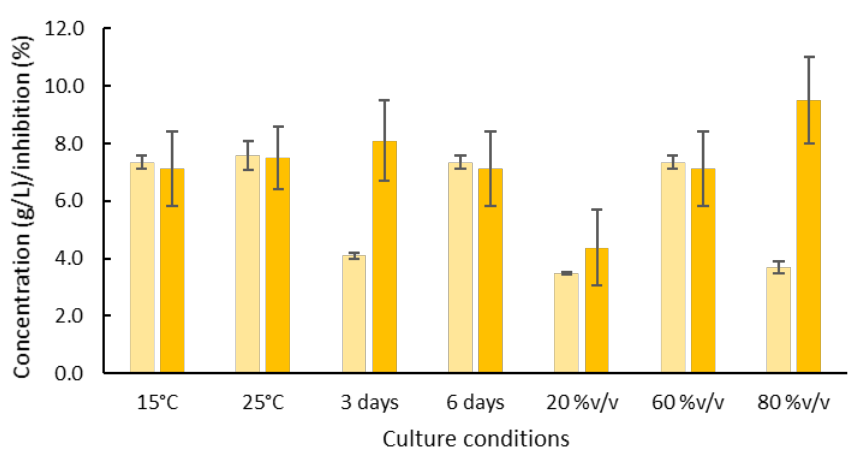
Figure 1. Effect of culture conditions: incubation temperature (15 and 25 ◦ C), incubation time (3 and 6 days), and growth medium composition: artificial seawater concentration (20, 60, and 80 % v / v ) on the biomass concentration and antibacterial activity on E. coli (AA) of the extract from cultures of R. rubra .